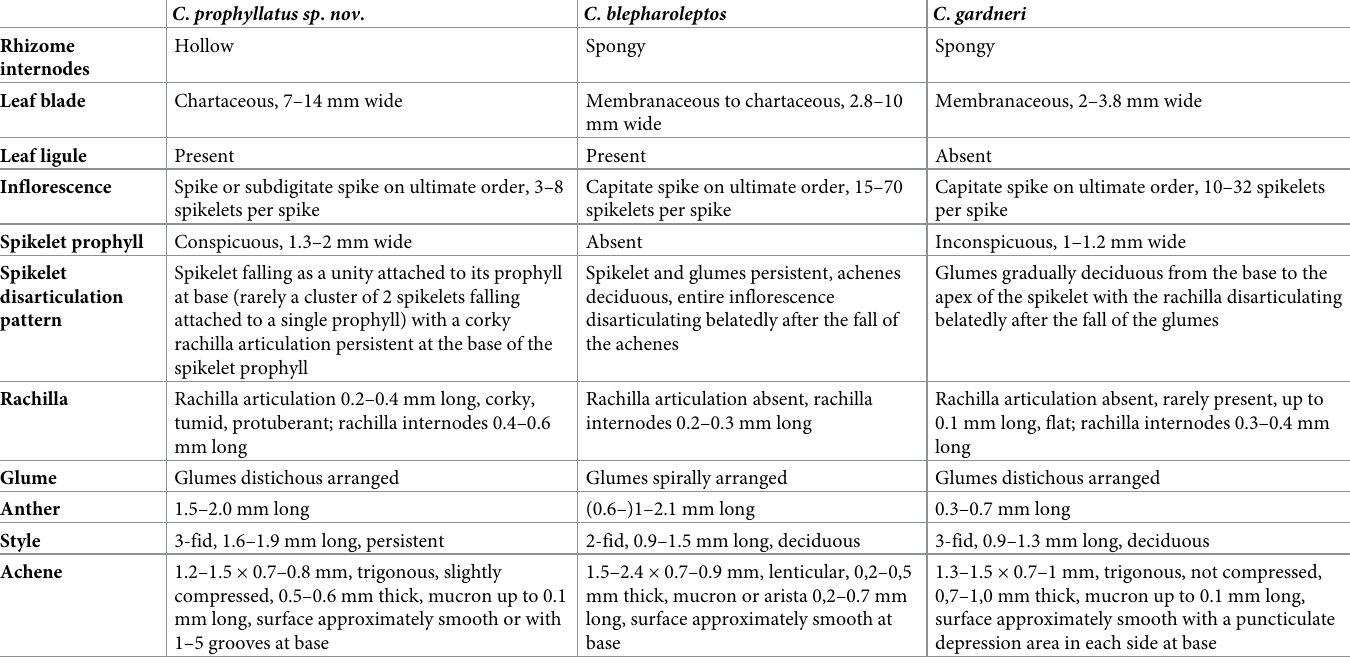
Table 2. Comparison of Cyperus prophyllatus with allied species in C . sect. Oxycaryum . C . prophyllatus sp . nov